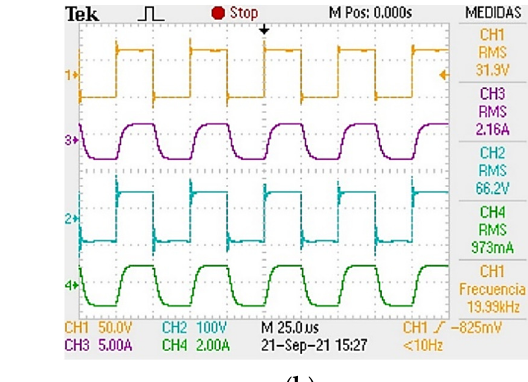
Figure 11. Block diagram of the experimental setup: ( a ) a DC variable source 0–120 V, ( b ) H Bridge